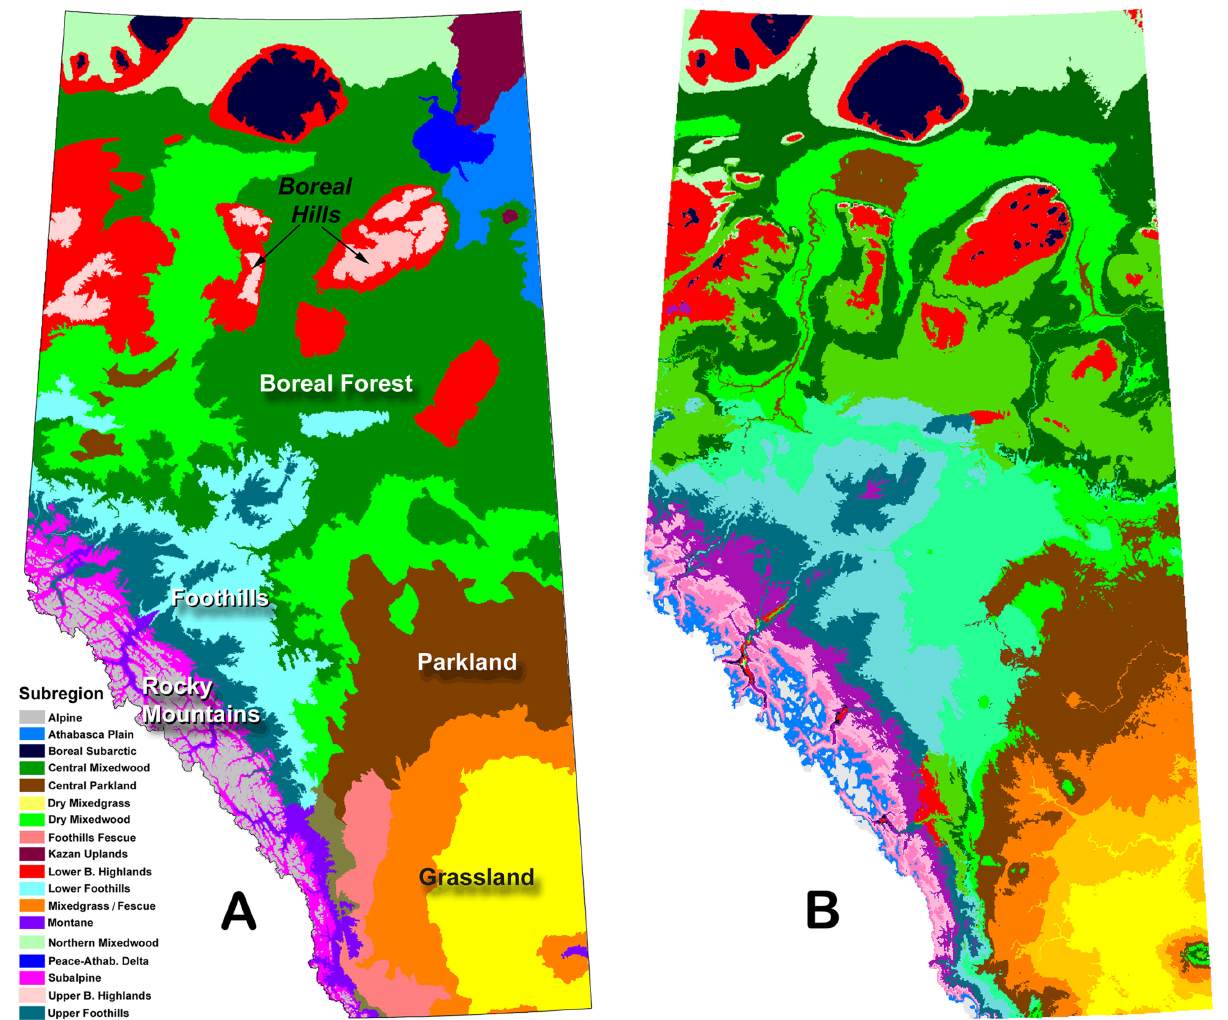
Fig 2. Comparison of classification systems. Panel A = Natural Subregions of Alberta. Panel B = Cluster analysis of ClimateWNA historical climate variables with k = 18